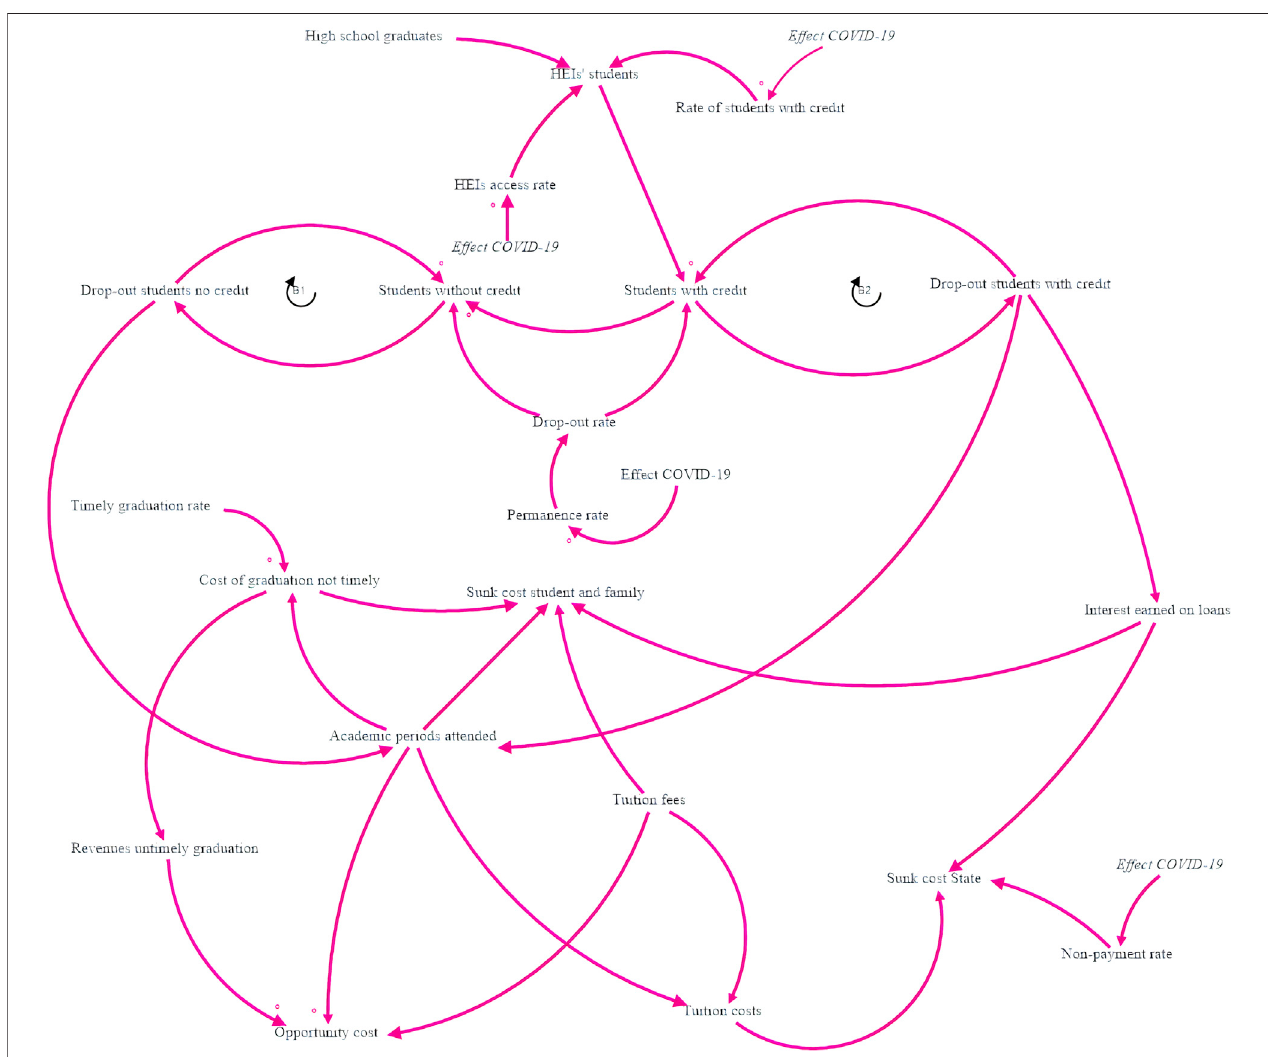
FIGURE 1 | Causal Loop Diagram. Note: B indicates that it is a balance loop. For the purposes of this diagram, positive relationships have no loadings on the